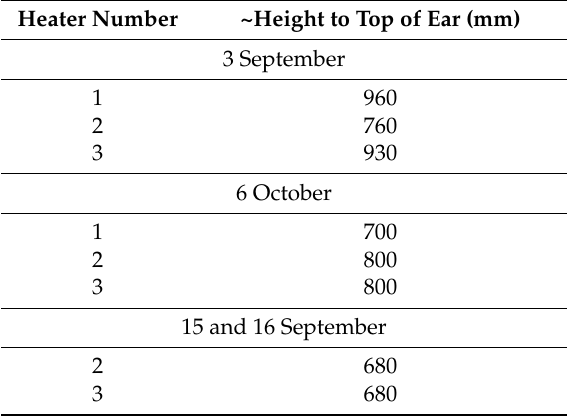
Table 1. Crop canopy height in heated plots in 2017 and